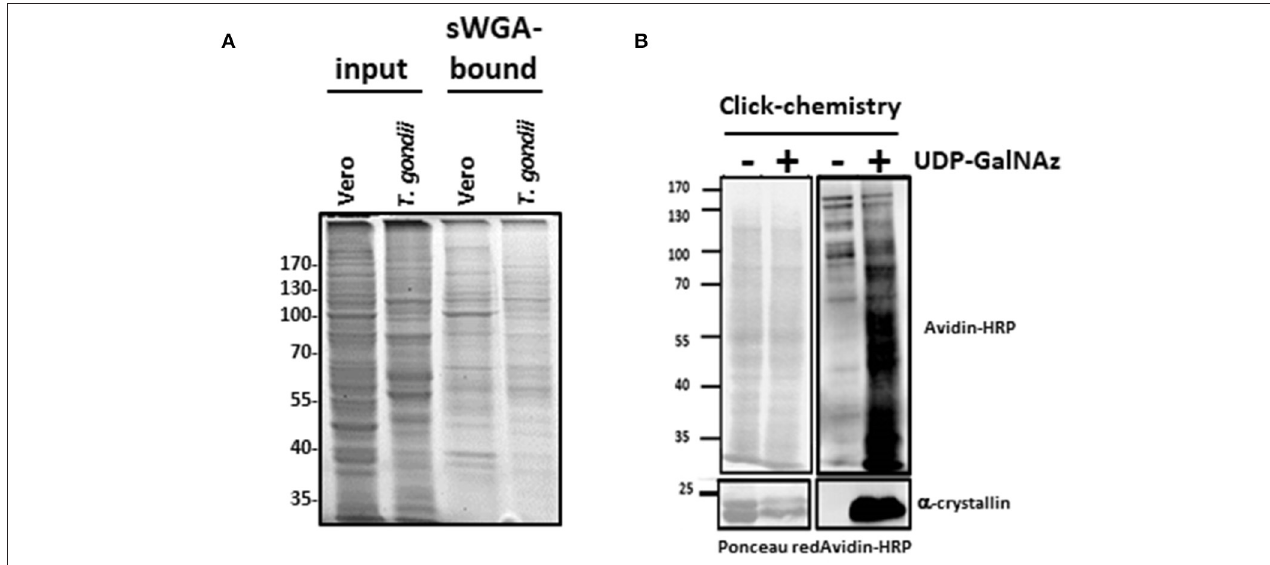
FIGURE 2 | (A) O -GlcNAc-bearing proteins from Vero cells (host cells) and T. gondii were enriched by sWGA-beads. Gels were brilliant blue stained. (B) T. gondii proteins were analyzed after labeling of the O -GlcNAc-bearing proteins by GalNAz and biotin alkyne using the Click-it TM O -GlcNAc enzymatic labeling system and the Click-it TM Glycoprotein detection kit as described in the Material and methods section. After labeling, T. gondii samples were separated by SDS-PAGE and Western blot was performed using HRP-labeled avidin to assess presence of the labeled O -GlcNAc-proteins. Equal loading was controlled by staining proteins with Ponceau red. Alpha-crystallin was used to control labeling